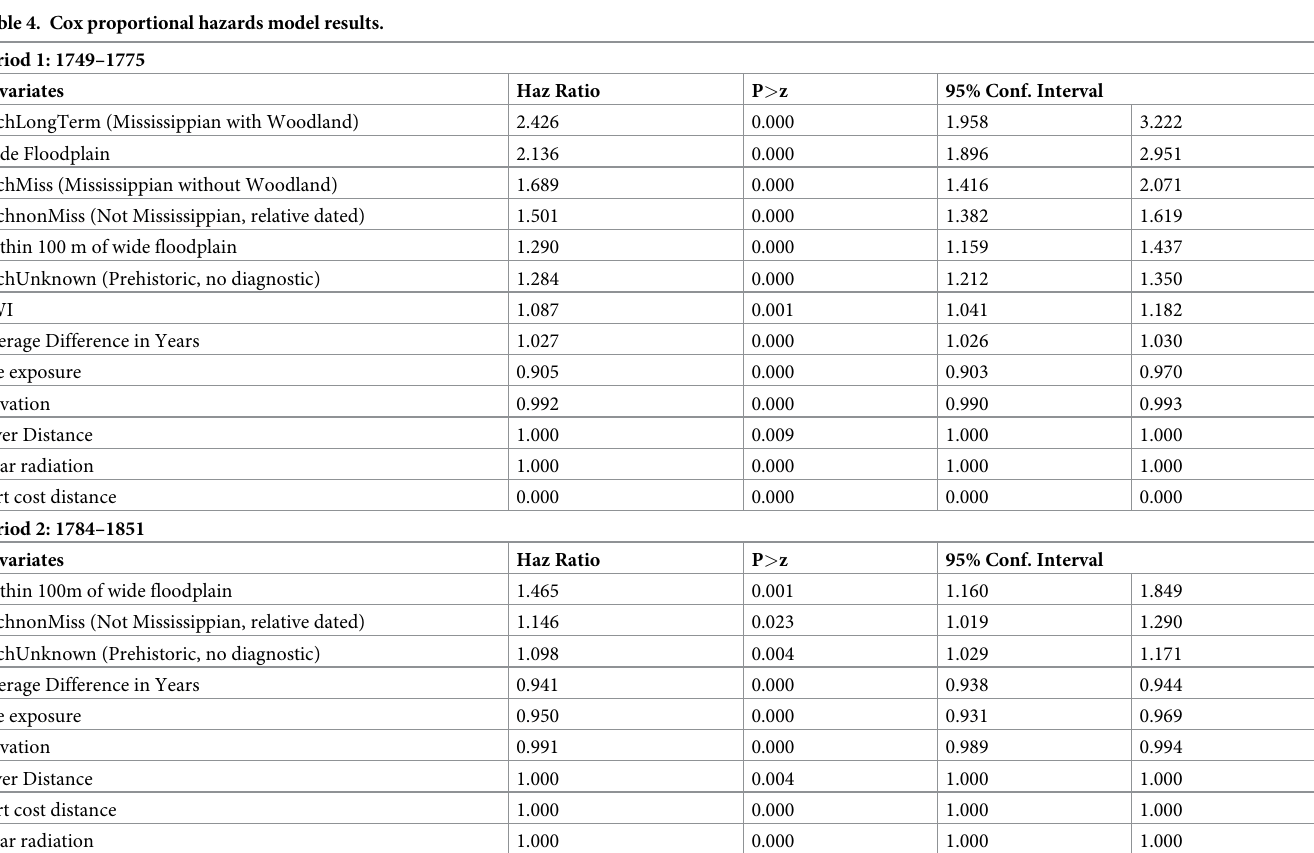
Table 4. Cox proportional hazards model